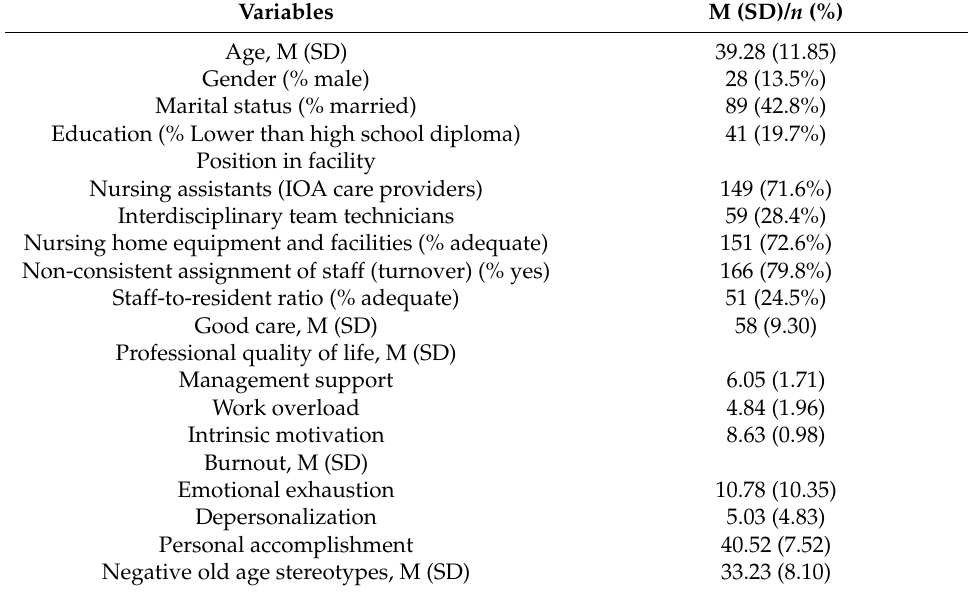
Table 1. Sample characteristics (N =